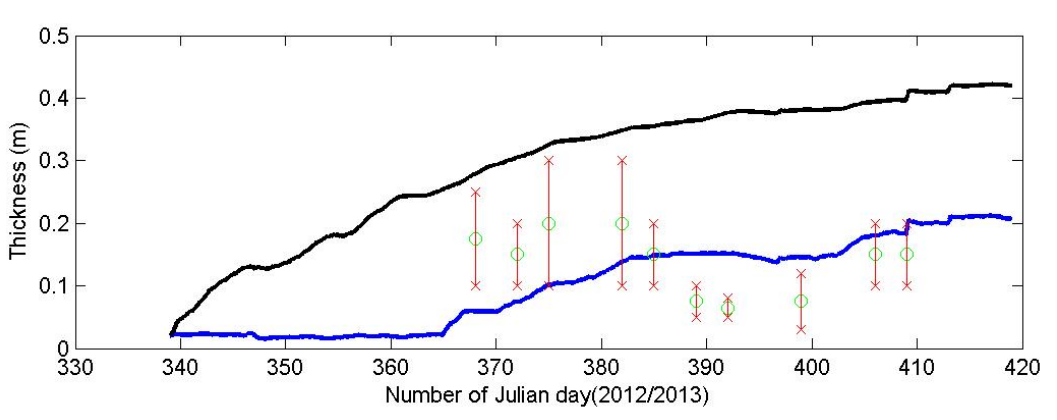
Figure 5. The modeled and observed level-ice thickness at the JZ-202 site. The lines show the modeled ice thickness without using SIC (black) and with using AMSR2 SIC (blue) as an input for the HIGHTSI model. The green dots are the mean observed SIT with standard deviation indicated by the red